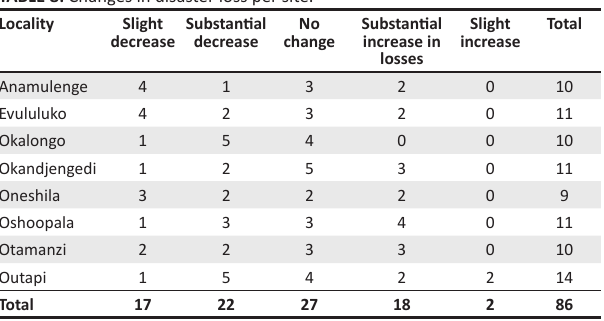
TABLE 8: Changes in disaster loss per site.